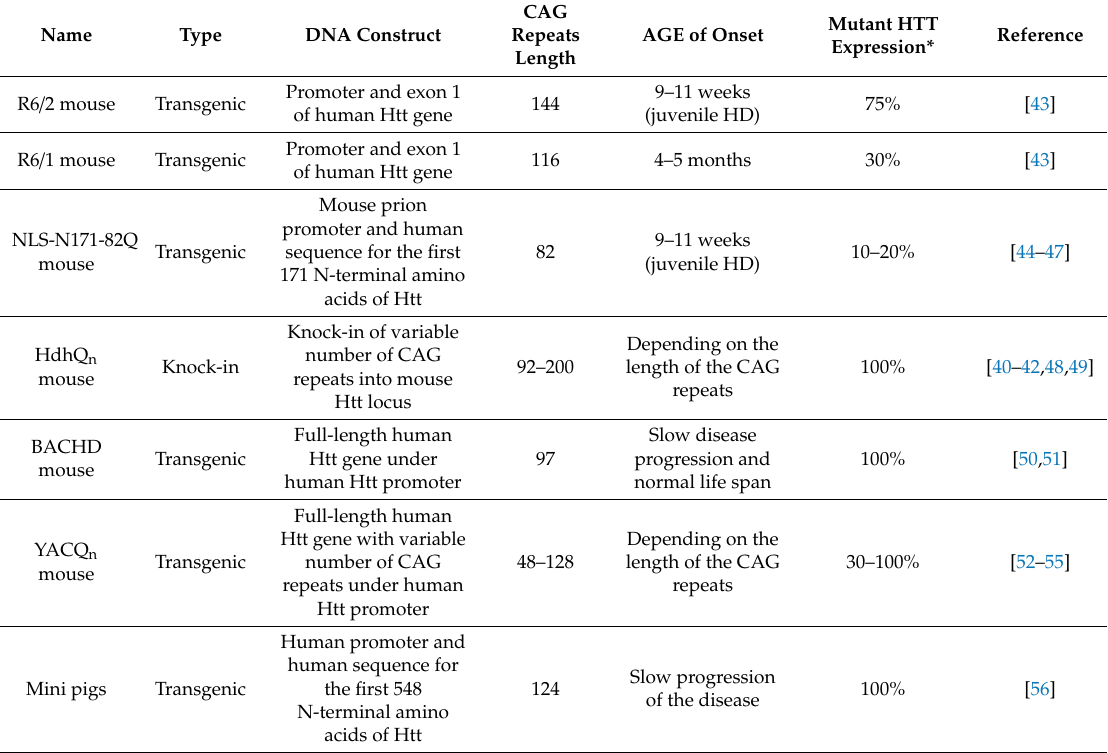
Figure 1. The scheme represents the main mechanisms contributing to muscle weakness and atrophy in HD and their interconnections. Dotted lines represent putative connections. Htt , Huntingtin. Created with BioRender.com. Table 1. Animal models for HD mentioned in the